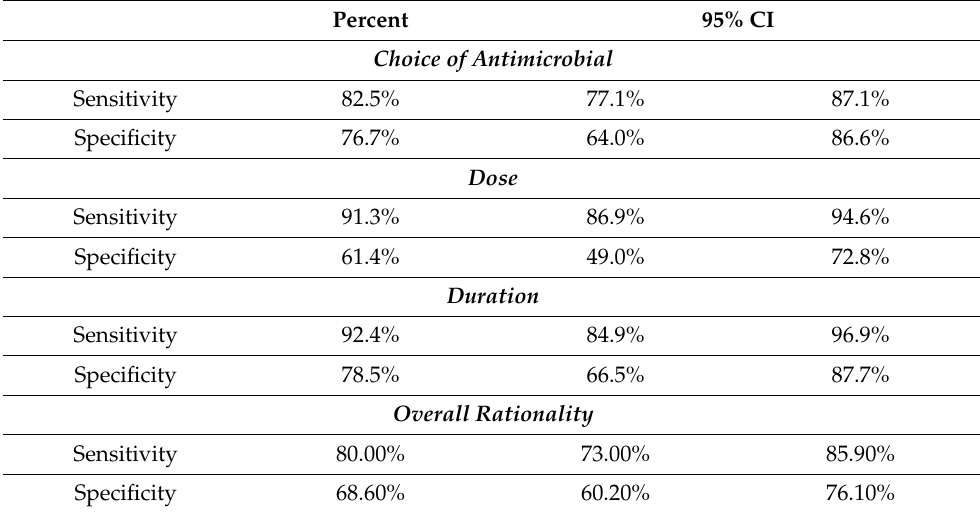
Table 3. Overall sensitivity and specificity estimates compared to gold